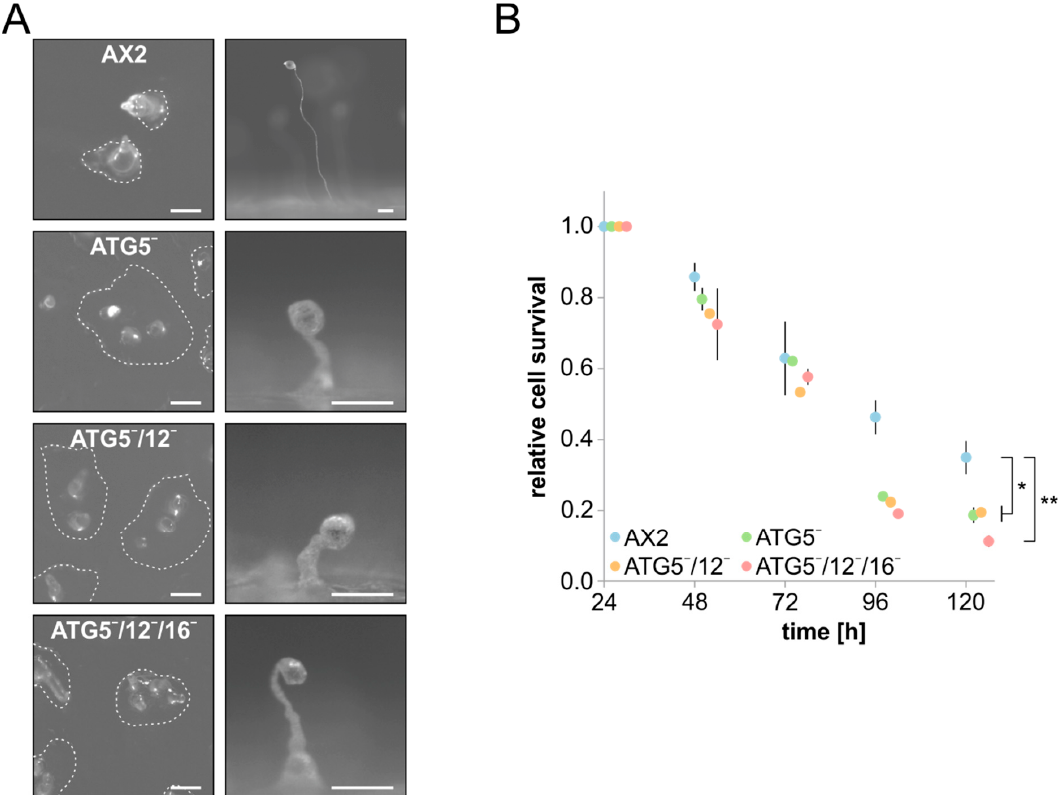
Figure 4. Development and cell survival upon nitrogen starvation of AX2 and mutant strains. ( A ) Development of AX2, ATG5¯, ATG5¯/12¯ and ATG5¯/12¯/16¯ cells on phosphate agar plates. 5 × 10 7 cells of each strain were plated homogeneously. On the left, the tipped mound stage for AX2 after 15 h, and for mutant cells after 30 h (top view), and on the right an exemplary fruiting body of AX2 after 24 h, and of mutant cells after 48 h (side view), is shown. The white dashed line encircles tipped mounds. Scale bars, 100 µm. Note the different scale for mutant fruiting bodies. ( B ) Cell survival of AX2, ATG5¯, ATG5¯/12¯ and ATG5¯/12¯/16¯ cells upon nitrogen starvation. AX2 and mutant strains were grown in SIH medium without amino acids, and cell survival was determined every 24 h for 5 days. Relative cell survival after 24 h was set to 1 for each strain. Cell survival of mutant cells was significantly reduced in comparison to AX2 after 96 and 120 h. Mean values and standard errors of the mean of three independent experiments are shown. For statistical analysis, one-way ANOVA and Tukey’s test as post hoc analysis were used. *, significant ( p -value < 0.05); **, very significant ( p -value < 0.01).